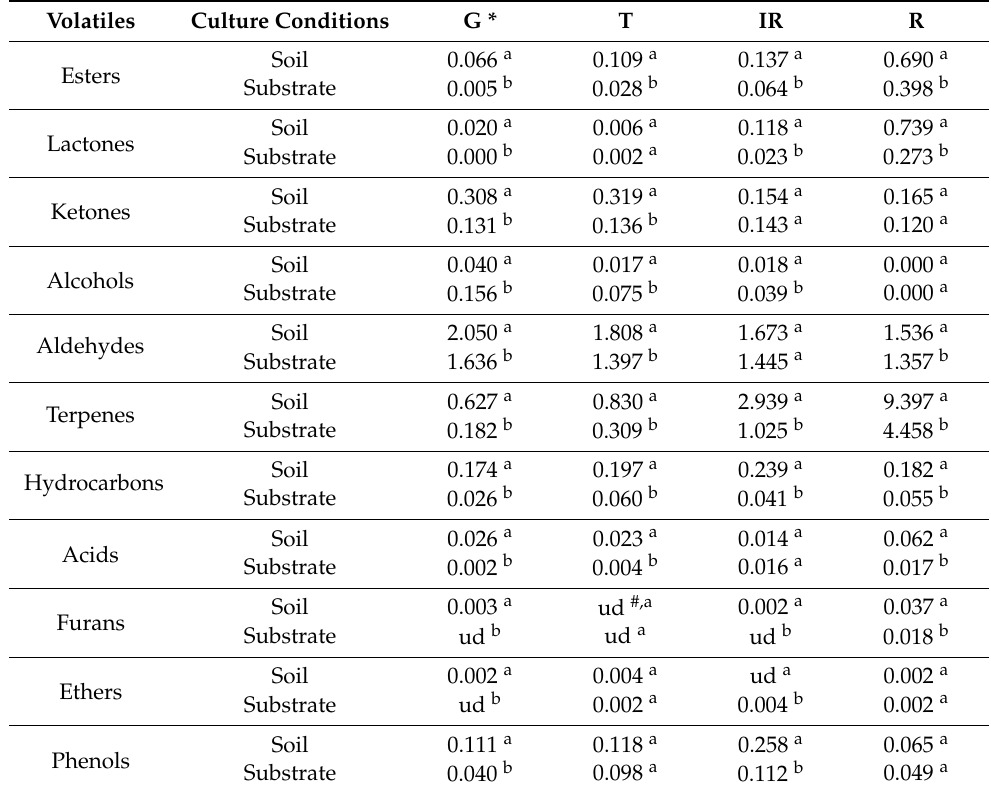
Table 2. Content of aroma volatiles ( µ g/g FW) in basal section of ‘Amaou’